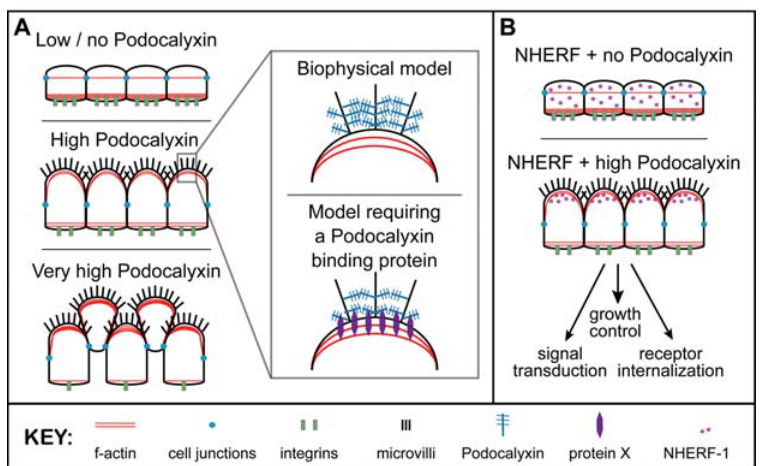
Figure 11. Model of Podocalyxin’s functions. (A) Cells expressing low or no Podocalyxin have well-defined cell-cell junctions and adhere well to the substratum. Overexpression of Podocalyxin leads to recruitment of f-actin to the apical membrane for formation of microvilli along with apical domain expansion and weakening of cell-cell junctions. Higher expression induces further recruitment of f-actin to the apical surface, which may lead to a decrease in basolateral actin and disruption of integrin-mediated cell-substratum adhesion. Two models are proposed to explain Podocalyxin’s mechanism of action. (B) In the absence of Podocalyxin expression NHERF-1 is localized throughout the cytoplasm, whereas in cells expressing high levels of Podocalyxin NHERF-1 is recruited to the apical membrane. Thus, Podocalyxin may regulate NHERF’s role in many biological processes.